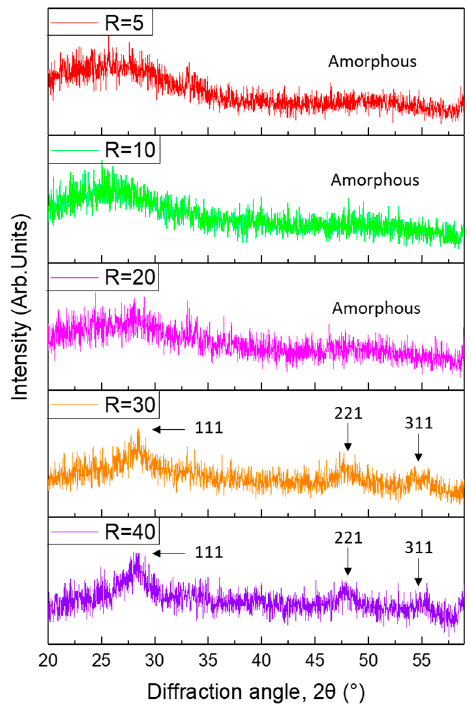
Figure 3. Low-angle X-ray diffraction (XRD) pattern of plasma-enhanced chemical vapor deposition (PECVD) deposited nc-Si:H films.